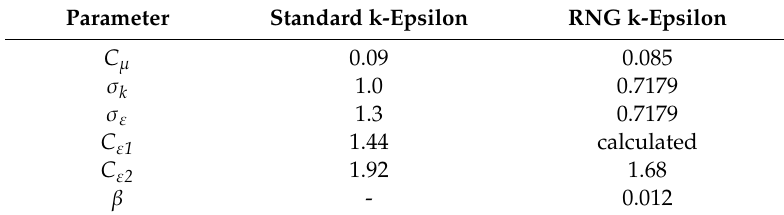
Table 1. Constants used in the governing